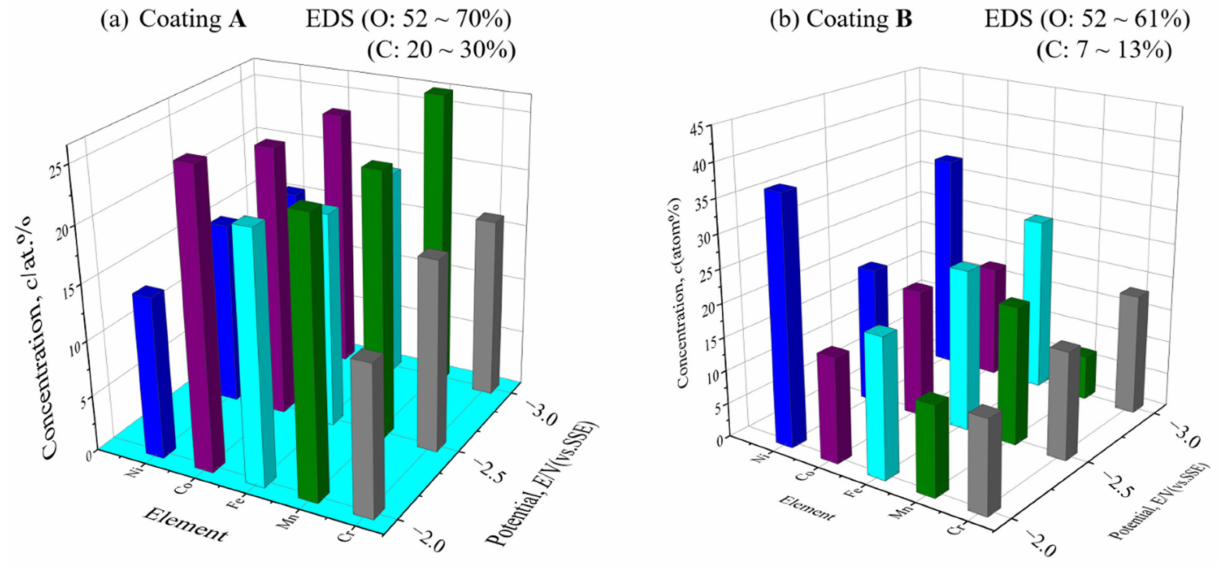
Figure 7. Atomic percentage of oxygen (O) and carbon (C) elements in coatings A ( a ) and B ( b ) de- posited at − 2.0 V, − 2.5 V, and − 3.0 V (vs. SSE) for 0.6 ks. Compositions were obtained by energy dispersive X-ray spectrometer (EDS). Table 2. Compositions and mixed configuration entropies ( ∆ Sm7, ∆ Sm5) of coatings obtained in solution B for 0.6